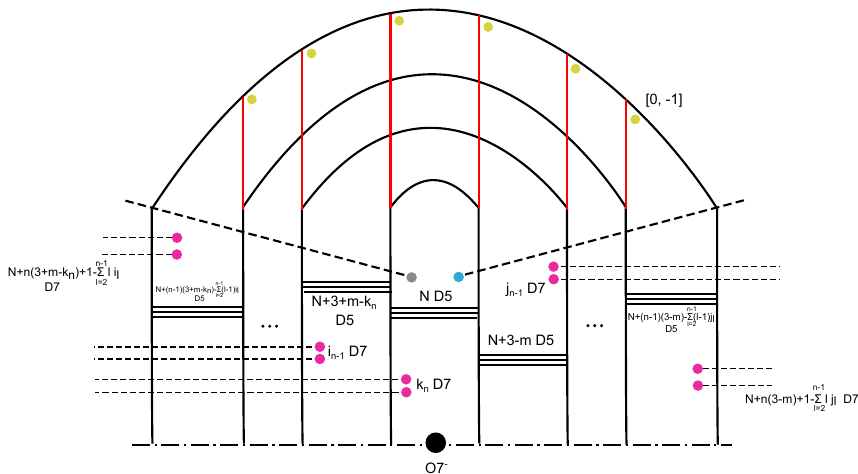
Figure 32 . Type IIB brane con(cid:12)guration after the two steps from the one in (cid:12)gure 30 when one O 7 (cid:0) -plane is